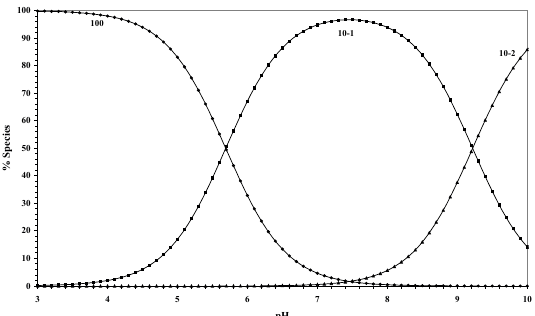
Figure 1. Concentration distribution of various species as a function of pH in the hydrolysis of [Pd(DAP)(H concentration of 1.25×10 -3 mol dm -3 , I = 0.1 mol dm -3 (NaNO ) and T = 25 ± 0.1 o 3